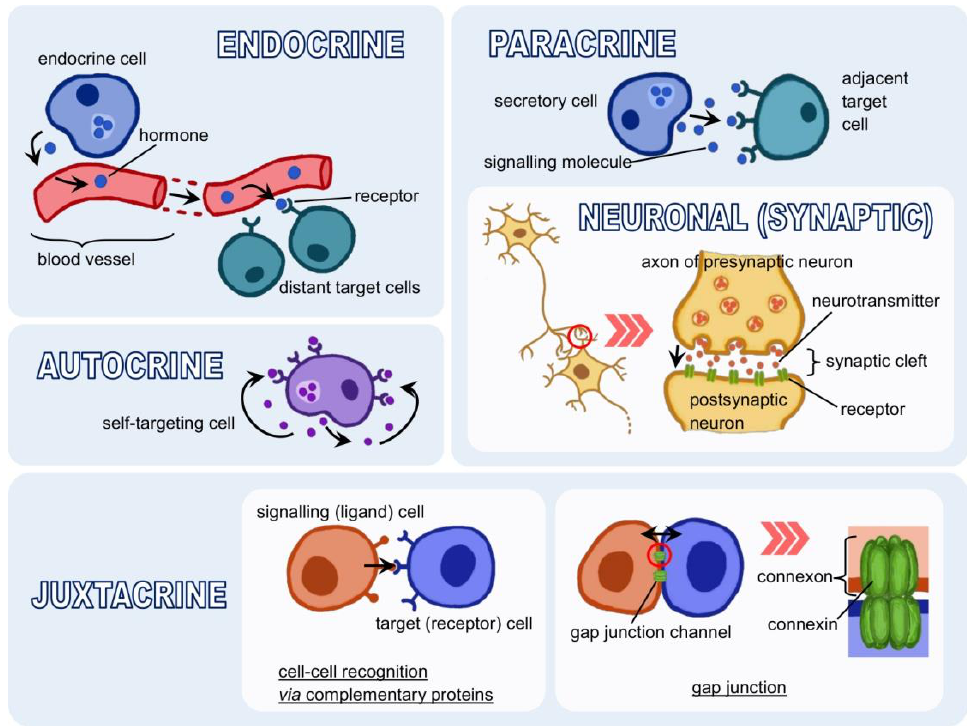
Figure 2. Forms of cell signalling: indirect (endocrine, paracrine, autocrine) and direct (juxtacrine). Endocrine signalling occurs via hormones. Hormones are produced by specialised cells, secreted into the bloodstream, and distributed throughout the body. With the blood- stream, they reach distant target cells. It is, therefore, long-distance signalling, but it oc- curs relatively slowly because it depends on the speed of blood flow [4,8,291]. The distance covered by the signalling molecule is shorter in paracrine signalling. It acts as a local car- rier and affects cells in the immediate vicinity. A specific form of this type of communica- tion is synaptic signalling. Two nerve cells (or a nerve cell and a target cell) are bound by